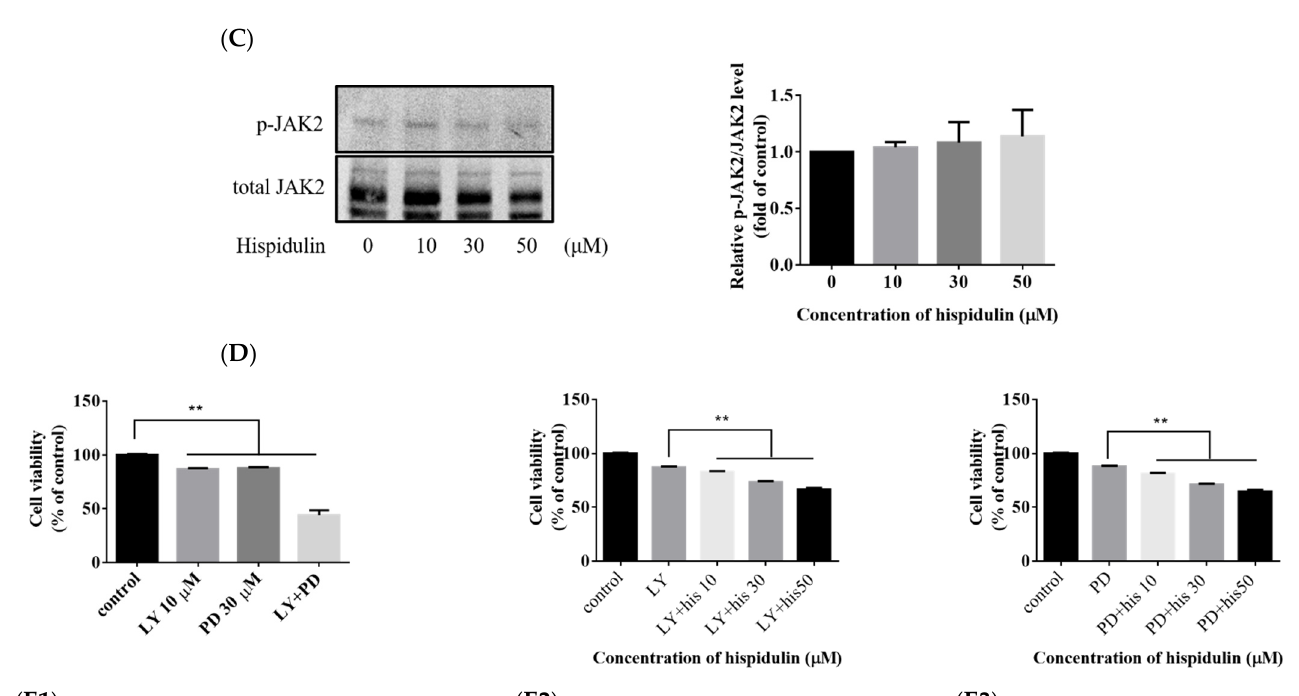
Figure 6. ( A ) Time course for hispidulin-inhibited AKT and ERK phosphorylation in A2058 cells. The A2058 cells were treated with 50 µM of hispidulin for the time course (upper panel). The data were normalized to the p-AKT or p-ERK level of control group (lower panel). The levels of p-AKT and p-ERK were determined by Western blot analysis. Equal loading of total proteins in each sample were verified by pan-AKT and total ERK expression. The A2058 cells were incubated with various concentrations of hispidulin (0, 10, 30, and 50 µM) for the indicated time. The levels of ( B ) p-AKT (after 1 h), ( C ) p-ERK (after 24 h), and ( D ) p-JAK2 were determined by Western blot analysis. Equal loading of total proteins in each sample were verified by pan-AKT, total ERK, and total JAK2 expression. The intensity of the bands obtained were quantified using the ImageJ software. ( E1 – E3 ) A2058 cells pretreated with LY294002 (LY; AKT inhibitor), PD98059 (PD; ERK inhibitor). or hispidulin for 24 h and cell survival as determined by the MTT assay. Results are expressed as percentage of control and mean ± SE, with ** p < 0.01 compared with the untreated control group (n = 5).